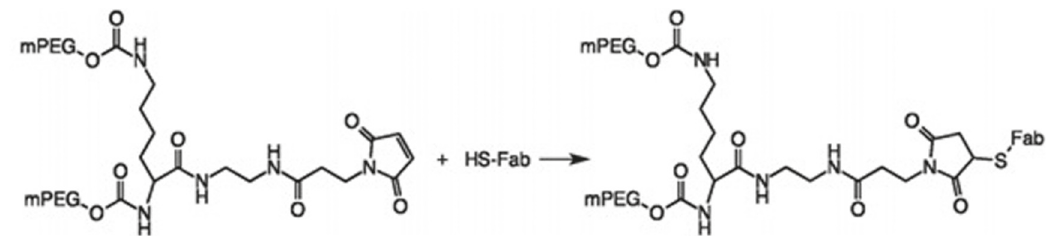
FIGURE 6 - Schematic conjugation of thiol PEGylation from antibody fragment with a PEG maleimide reagent (representing CIMZIA® conjugation).